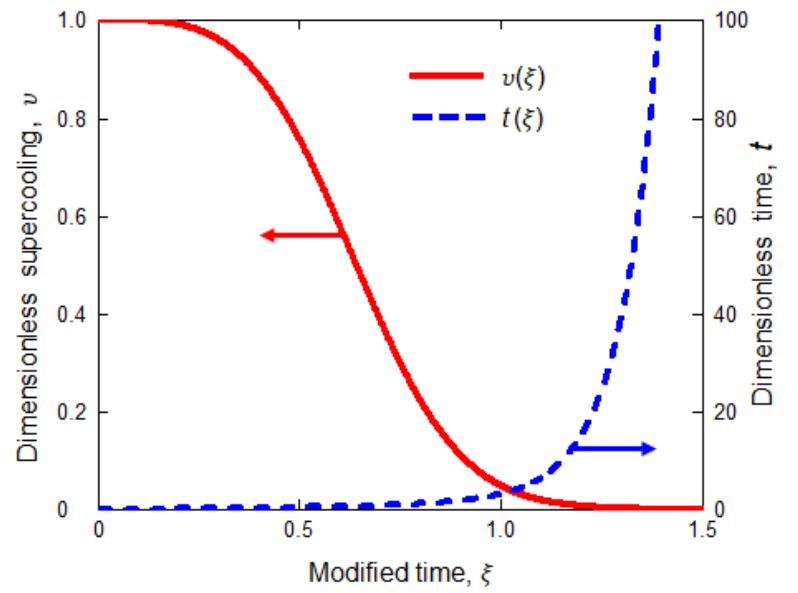
Figure 4. The dimensionless supercooling υ = ∆ T ∆ The physical parameters are typical for metallic alloys: u 0 = 10 − 2 , B = 14.92, ∆ T 0 = 300 o C, p =